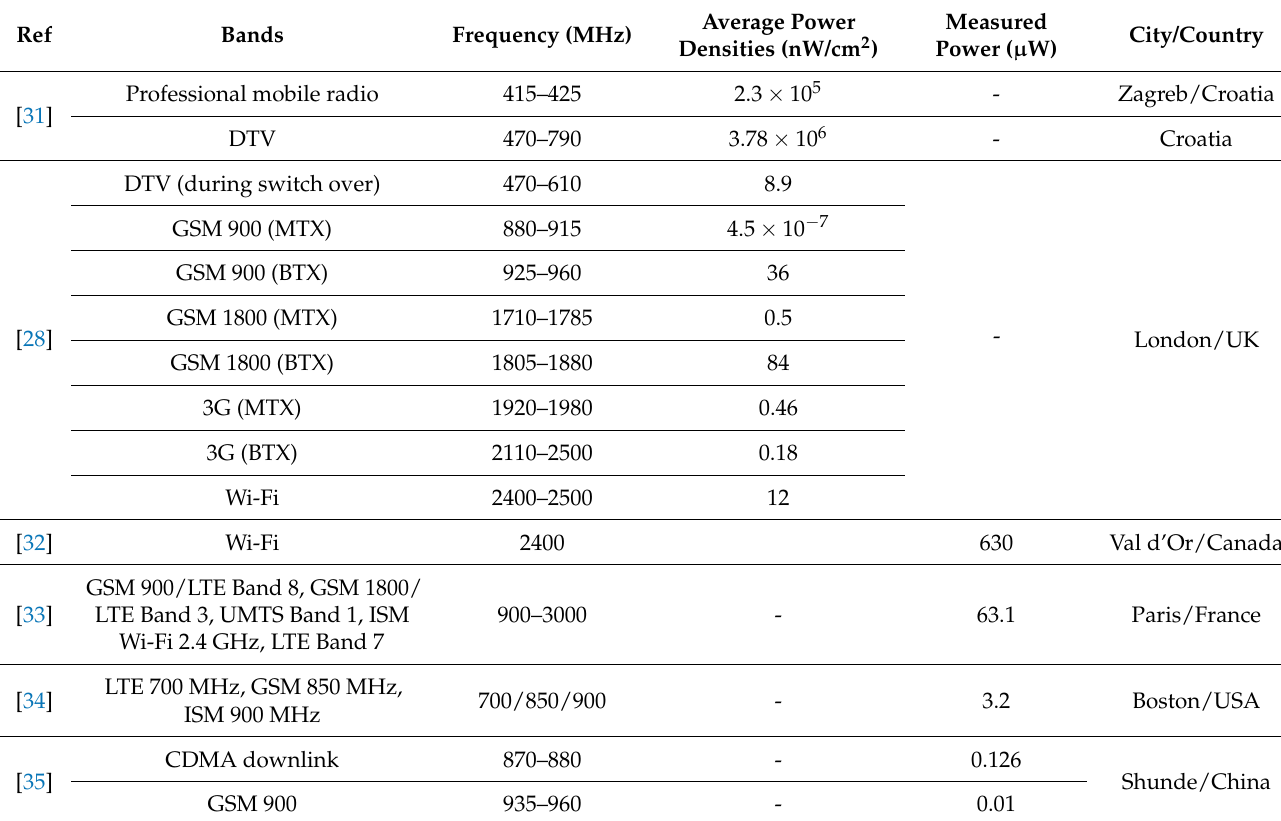
Table 2. Various ambient RF power